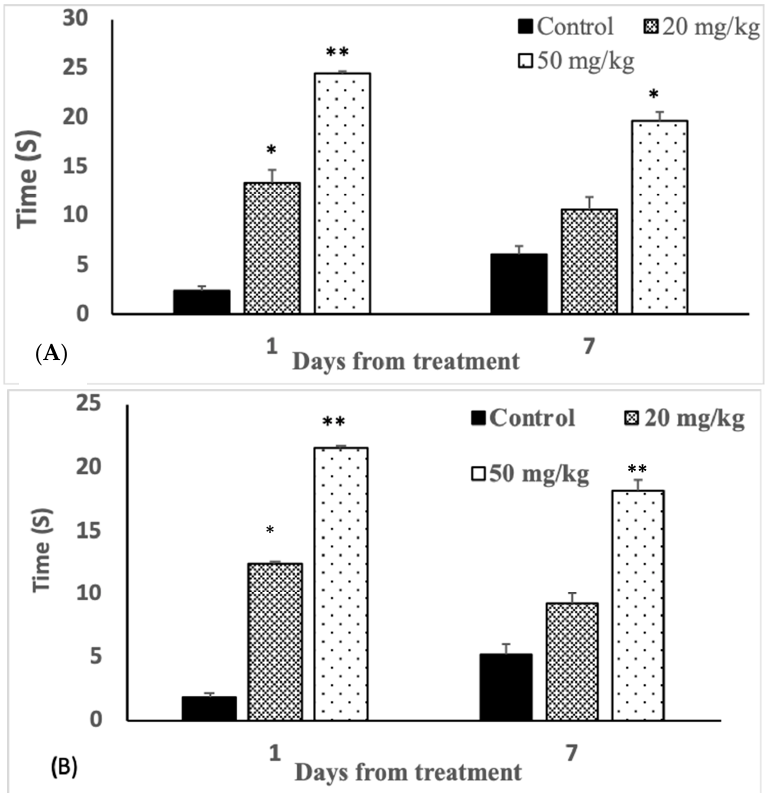
Figure 1. the effects of Judo 40 on the reaction time of rats ( n = 9) treated either with Judo 40 (50 and 20 mg/kg) or the control (corn oil) as evaluated using ( A ) tail flick and ( B ) hot plate tests on the posttreatment days one and seven. The reaction time was measured in seconds. Results are expressed as mean + SEM, * p < 0.05, ** p < 0.01.